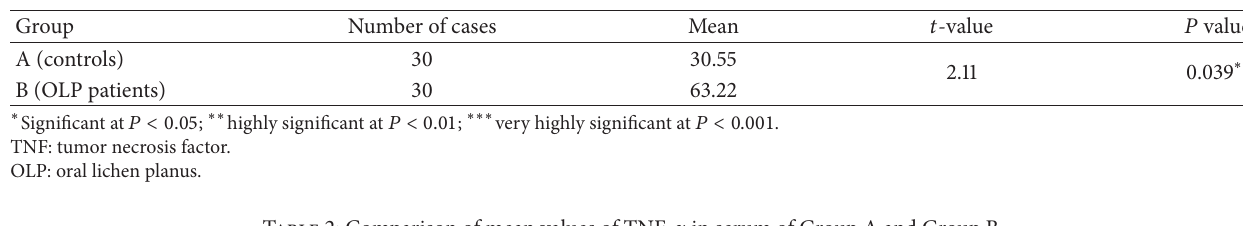
Table 2: Comparison of mean values of TNF- 𝛼 in serum of Group A and Group B.